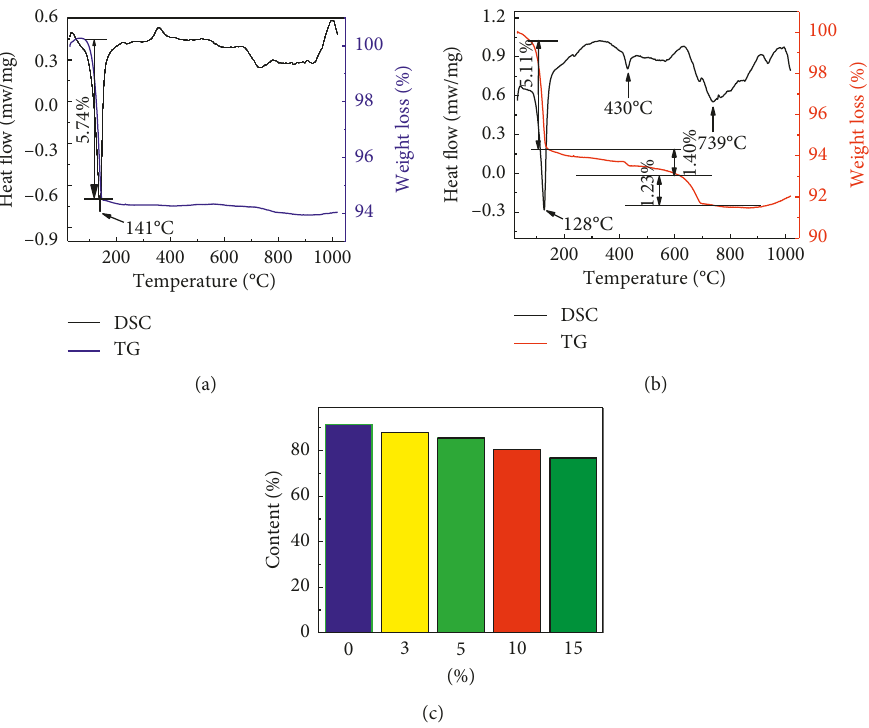
Figure 7: The hemihydrate content of R-CP: (a) DSC/TG of R-CP-0; (b) DSC/TG of R-CP-10; (c) TCA results.